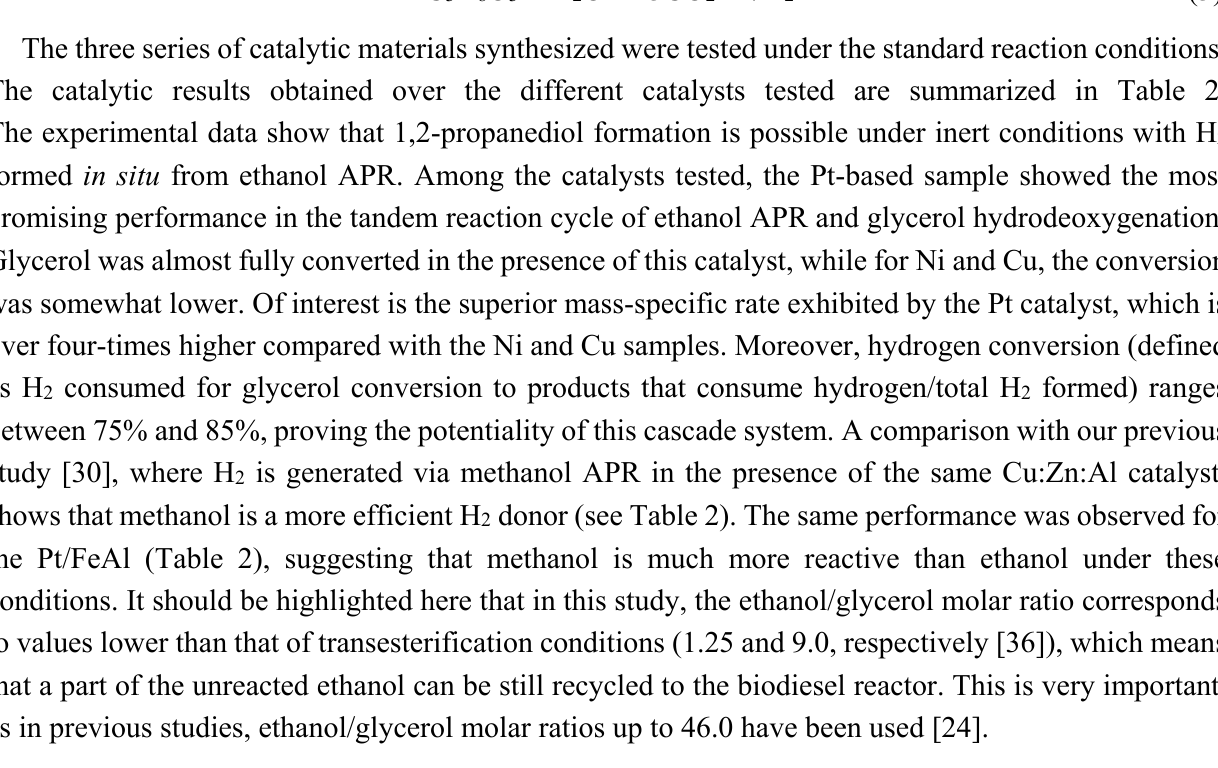
Table 2. Catalyst screening results under inert atmosphere, standard conditions: 3.5 MPa·N